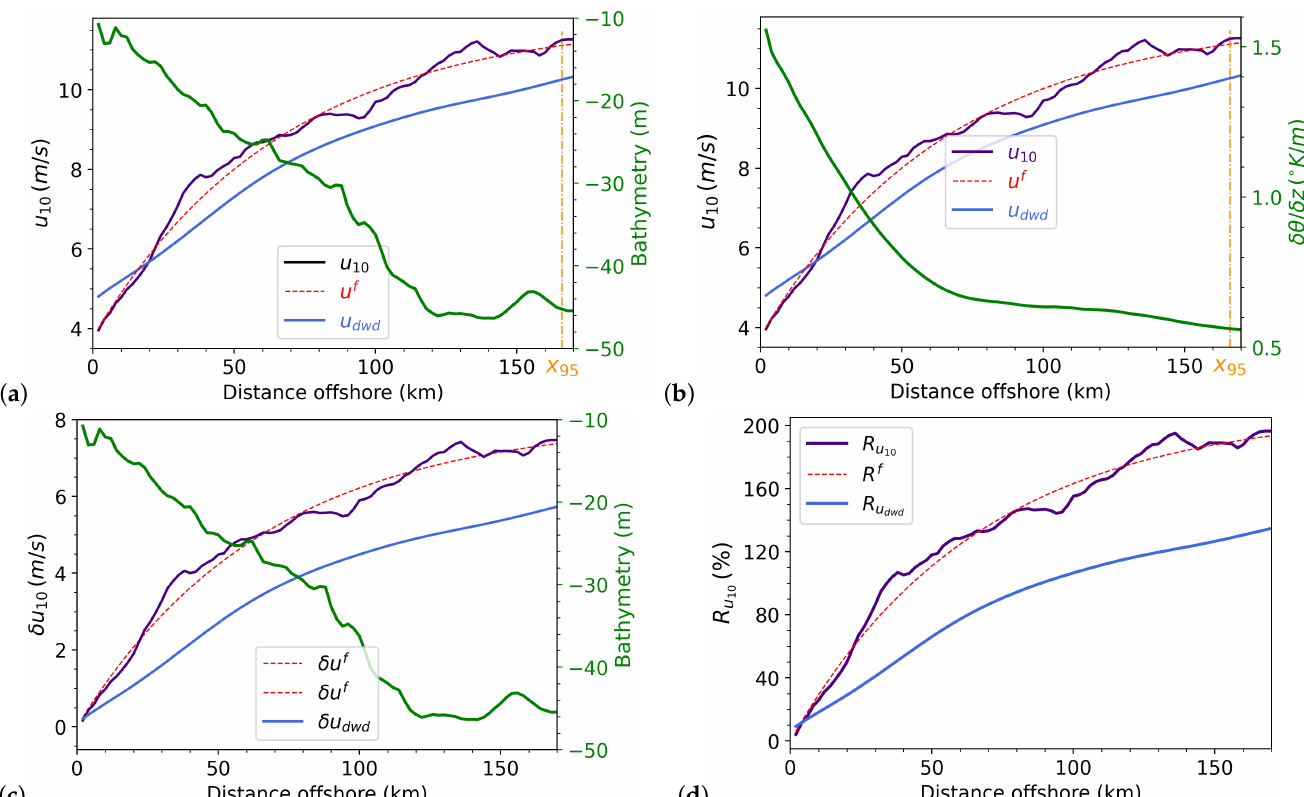
Figure 7. ( a , b ): Corresponding horizontal wind speed gradient of 10 m wind speed from SAR (purple) and DWD (blue) with superimposed curves for bathymetry (green) ( a ) and for thermal stability (green) ( b ). The orange dashed line at x 95 marks the adjustment distance according to Equation (12). ( c , d ): Wind speed increase δ u 10 ( c ) and normalised wind speed increase R u purple and blue curves, respectively, refer to SAR and DWD. The red curves in ( a – d ) corresponds to the fitted model given by Equations (10), (14) and (15),